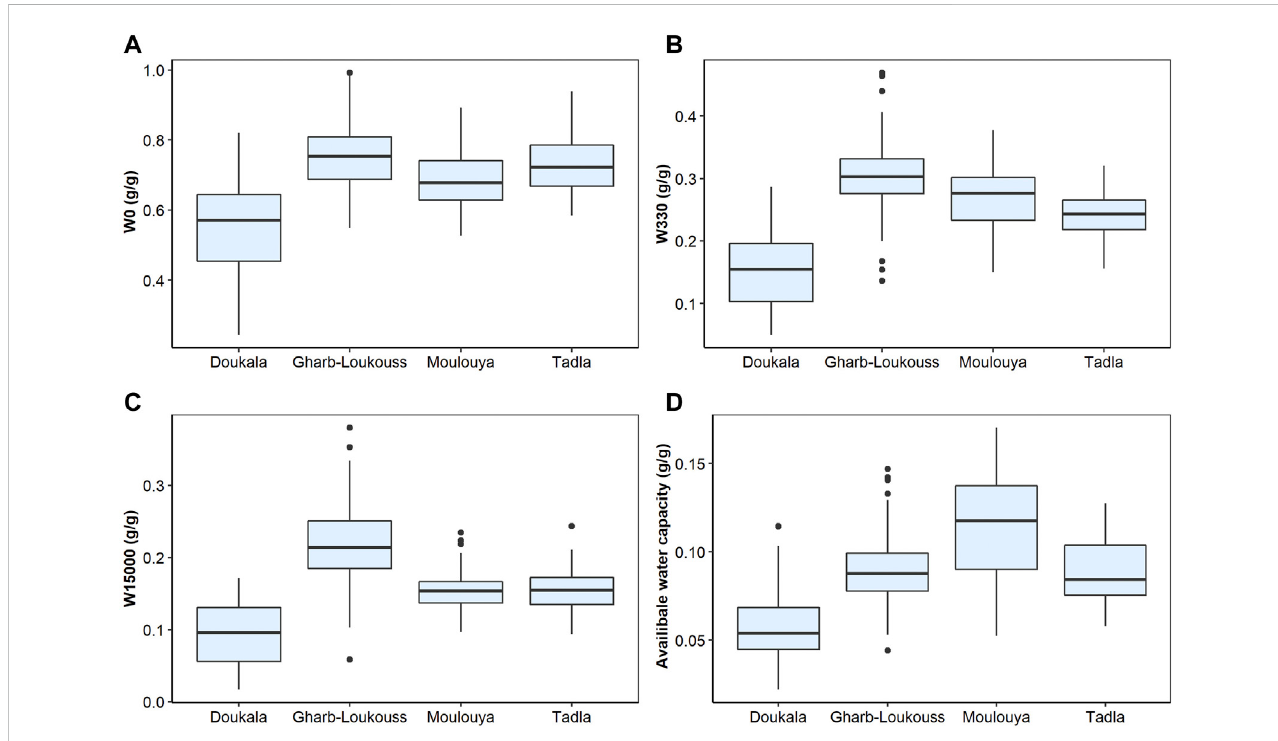
FIGURE 4 Gravimetricwater content at (A) saturation (w 0 ) , (B) fi eldcapacity(w 330 ), (C) wilting point (w 15000 ), and (D) available water capacity for differentregions in